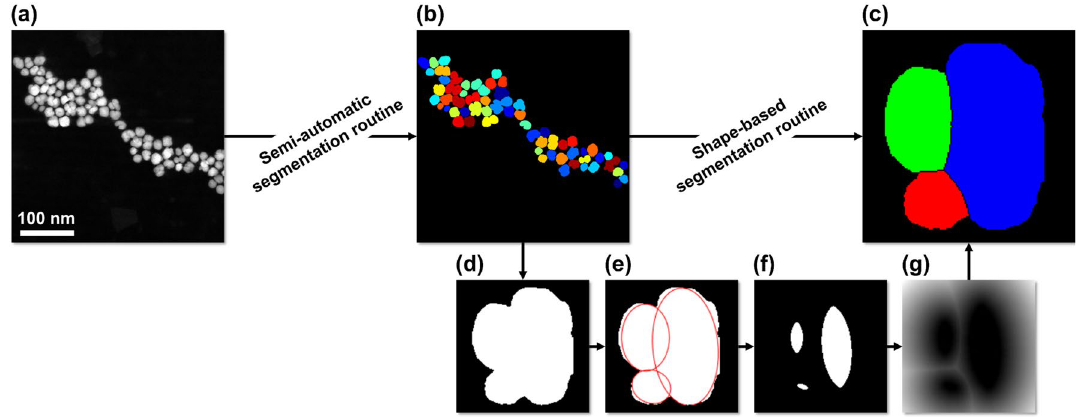
Figure 6. Schematic representation of the multi-stage segmentation routine used for the determination of the particle size and core size distribution. ( a ) Original low-magnification HAADF-STEM image of the IONFs. ( b ) HAADF-STEM image segmented into individual particles by the semi-automatic segmentation routine from Neumann et al. 45 . ( c ) Single IONF segmented into several cores by a shape-based segmentation routine. ( d ) Binary image of a single segmented IONF. (e) Shape of the IONF and its individual cores approximated by ellipses based on the DTECMA algorithm 64 . ( f ) Shape markers determined on the basis of the ellipses from ( e ). ( g ) Outer Euclidean distance transform of the shape markers from ( f ) used as the marking function for the watershed segmentation of the IONF into its